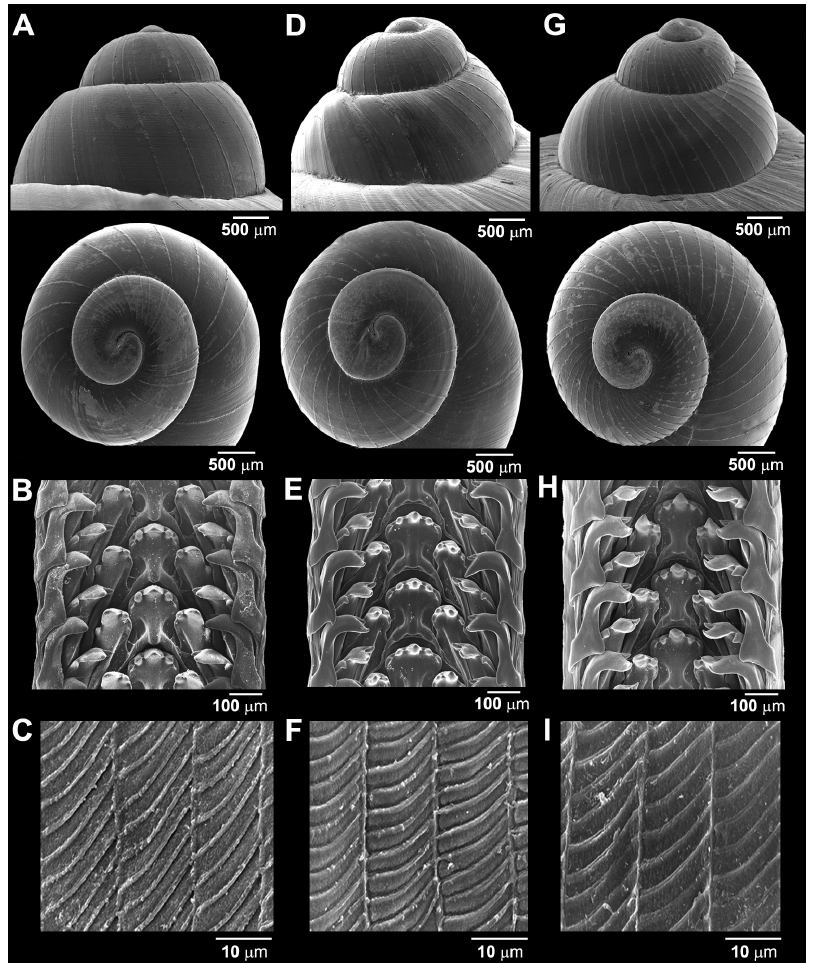
Figure 5. SEM pictures of (A, D, G) side and top views of protoconch, (B, E, H) radula morphology, and (C, F, I) surface sculpture of jaw of Cyclophorus species. (A–C) Cyclophorus fulguratus s.s. specimen CUMZ 1327 from Khao Chakan, Sra Kaeo (Clade A; Fig. 1B). (D–F) Cyclophorus rangunensis specimen CUMZ 1781 from Thepmuangthong Temple, Uthaithani (Clade C; Fig. 1B). (G–I) Cyclophorus abditus sp. nov. paratype CUMZ 1828 from the type locality (Clade B; Fig. 1B).